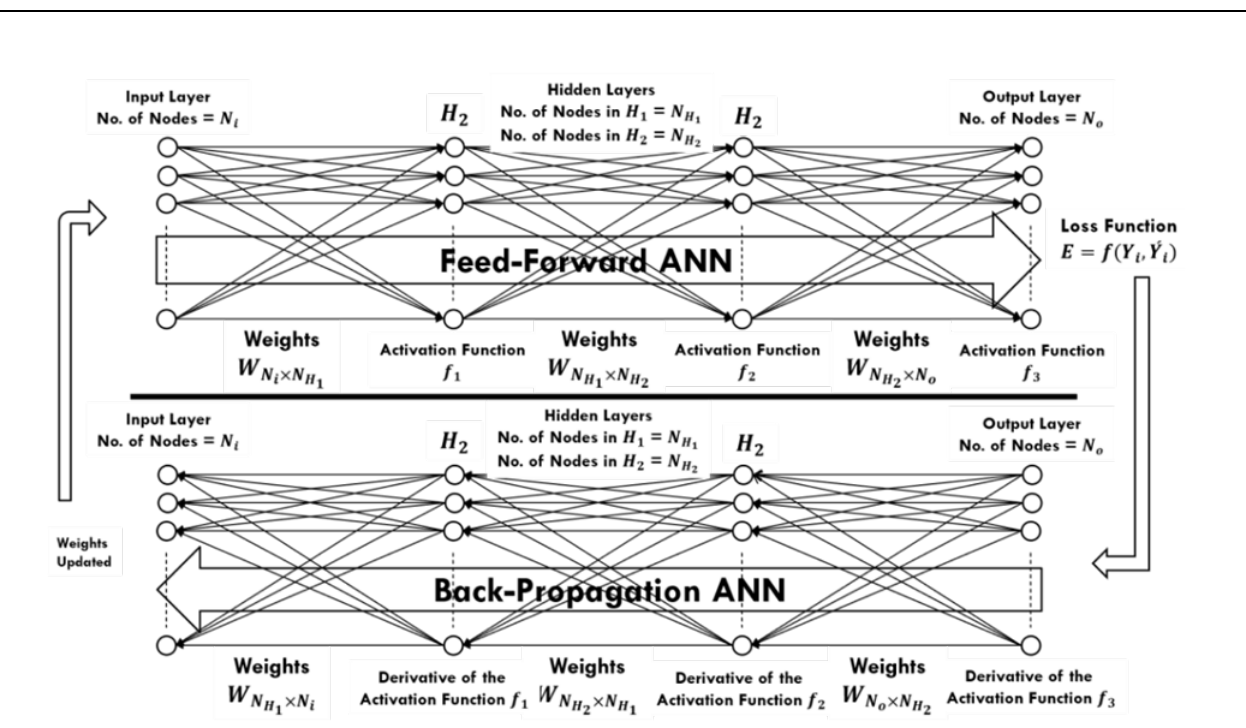
Figure 4. Generalized Schematic of ANN. Table 3. Summary of the Models Generated . Table 4. Parameters of the ANN model for all PSPP